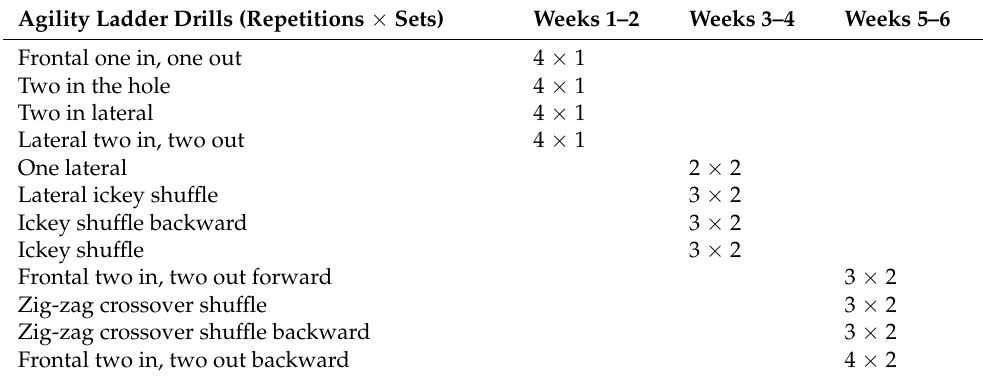
Table 1. The agility ladder exercises performed during the intervention program. Rest intervals between repetitions lasted 30 s. Rest intervals between sets lasted 60 s.